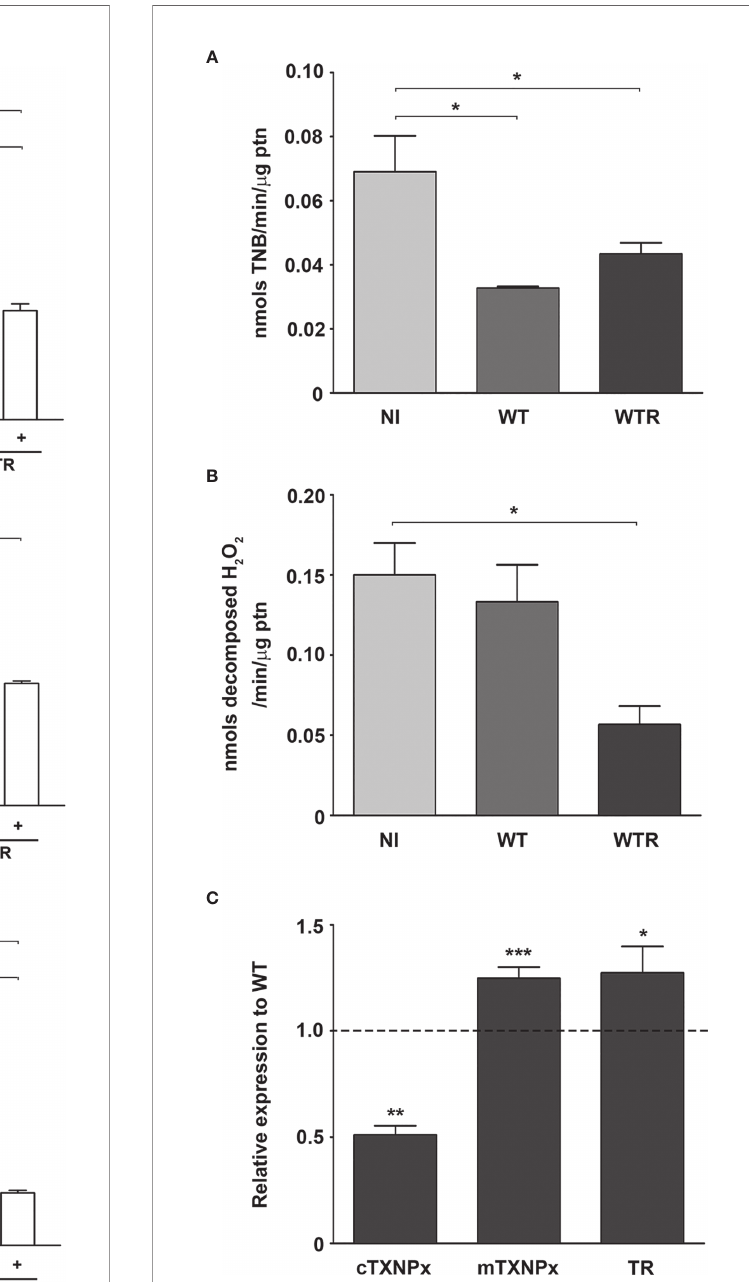
FIGURE 3 | Citrate synthase (CS) and catalase activities of Aedes aegypti were downregulated by the infection with Strigomonas culicis wild-type (WT) and hydrogen peroxide (H 2 O 2 )-resistant (WTR) strains, respectively. (A) CS and (B) catalase activities in midguts of non-infected (NI) and WT- and WTR- infected females fed with 10% sucrose ad libitum 4 dpi (*p = 0.05). Activities were performed in pools of 15 guts. (C) Transcript levels of cytosolic tryparedoxin peroxidase (cTXNPx), mitochondrial tryparedoxin peroxidase (mTXNPx), and trypanothione reductase (TR) of WTR during midgut infection (*p = 0.01, **p = 0.007, ***p = 0.003). Gene expression was normalized using the transcript levels of WT strain (dashed line). Glyceraldehyde 3-phosphate dehydrogenase (GAPDH) was used as the endogenous control. Signi fi cant p- values were obtained by Mann – Whitney test, and error bars represent the mean ± SEM of three independent